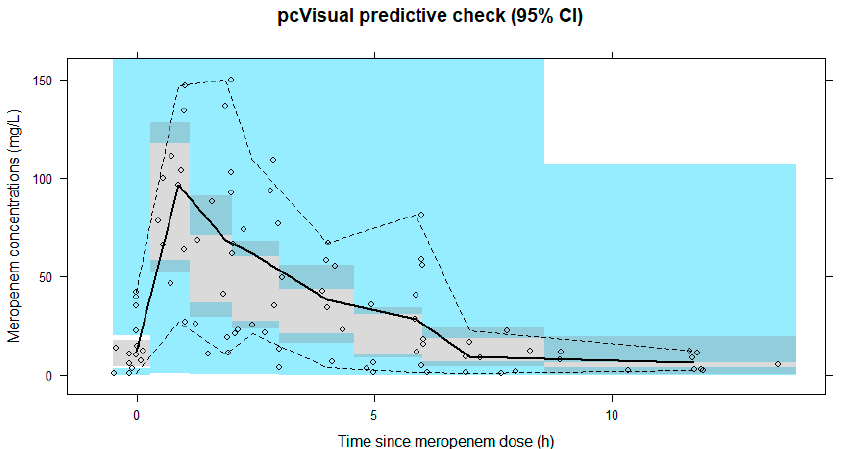
Figure 1. Prediction-corrected visual predictive check plot. The prediction-corrected visual predictive check plot shows that the 5th to 95th percentiles of the predicted data overlap most of the observed data based on time since meropenem dose. Open diamonds, plasma meropenem concentrations; solid line, median; lower and upper dashed lines, 5th and 95th percentiles of the observed data, respectively; shaded areas, 95% confidence intervals for simulated predicted median, 5th percentile, and 95th percentile constructed from 5000 simulated data sets of individuals from the original data set.